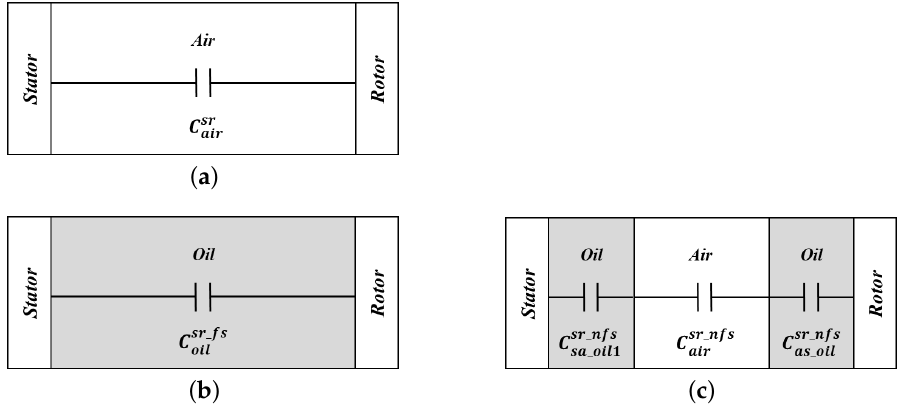
Figure 9. stator-to-rotor capacitance circuits: ( a ) without cooling oil, ( b ) oil-filled slot, and ( c ) oil-non- filled